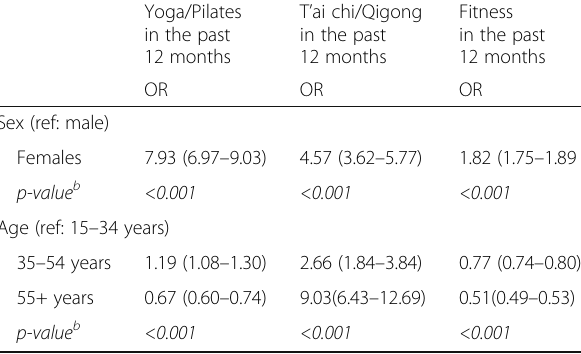
Table 2 Adjusted a odds ratios (OR), and their 95% confidence intervals (95% CI), of any participation in yoga/Pilates, t ’ ai chi/ qigong, and fitness in the past 12